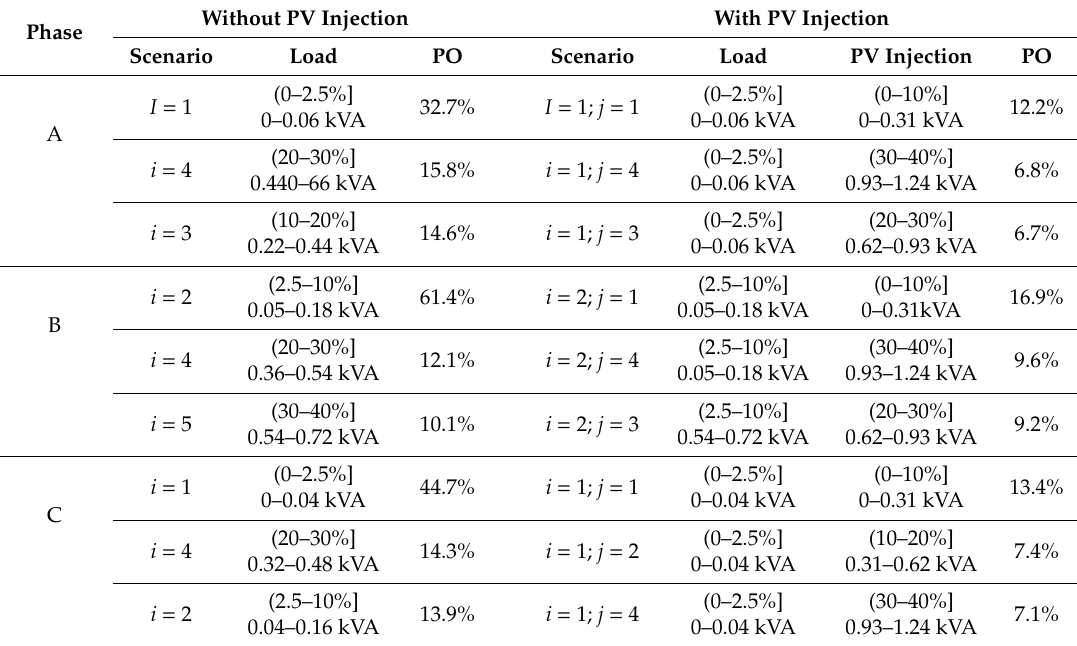
Table 4. Scenarios of greater probability for each phase.